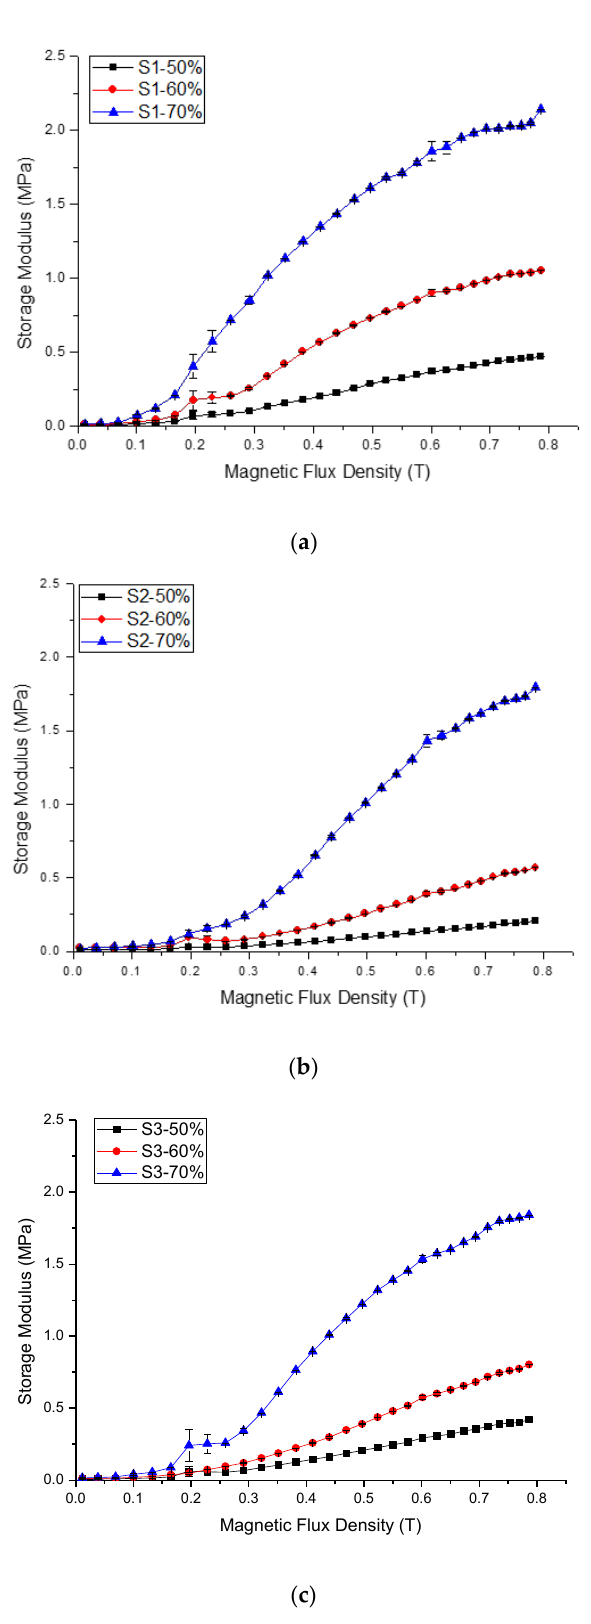
Figure 3. Shear storage modulus as a function of magnetic flux density with different CIPs compositions for ( a ) Sample 1, ( b ) Sample 2 and ( c ) Sample 3.